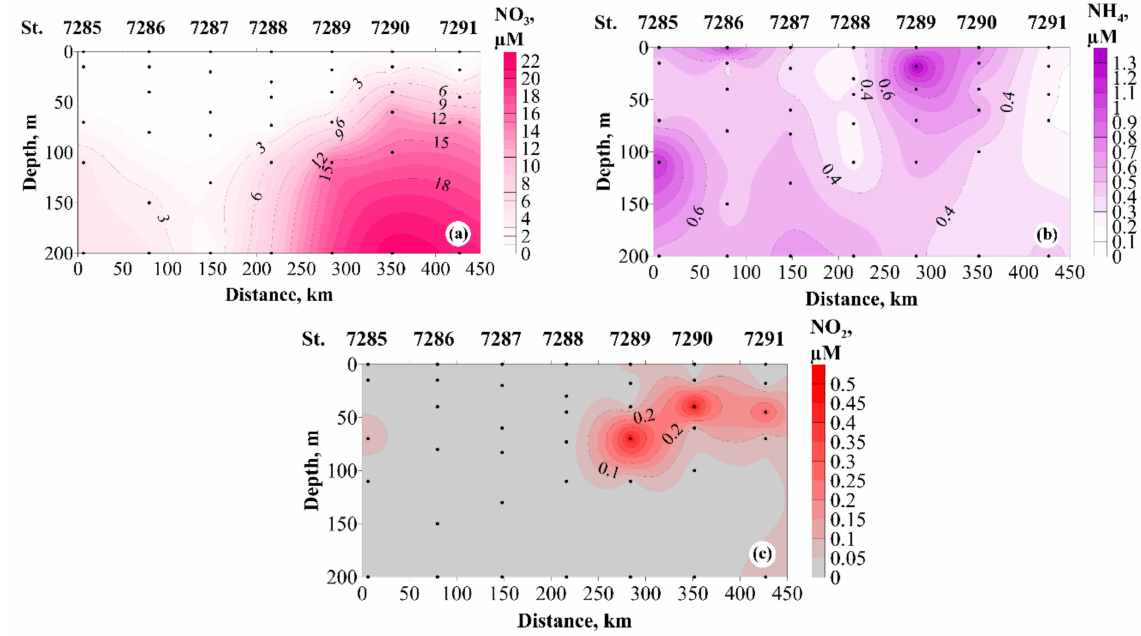
Figure 9. Distribution of nitrates (NO 3 , µ M) ( a ), nitrites (NO 2 , µ M) ( b ), and ammonium nitrogen (NH 4 , µ M) ( c ) over the